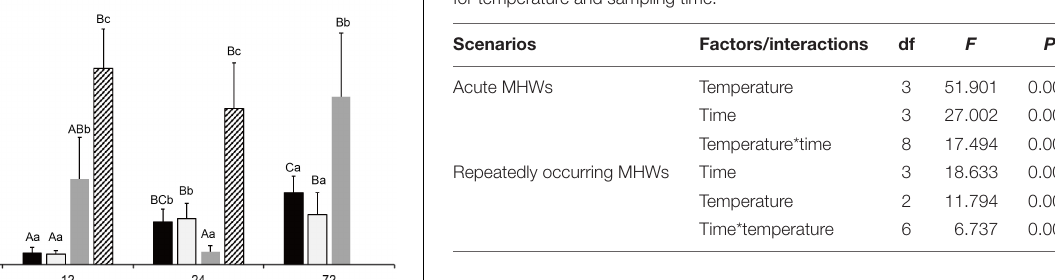
TABLE 3 | Two-way ANOVA results for relative expression of HSP70 in pearl oysters exposed to acute and repeatedly occurring MHWs scenarios accounting for temperature and sampling time.